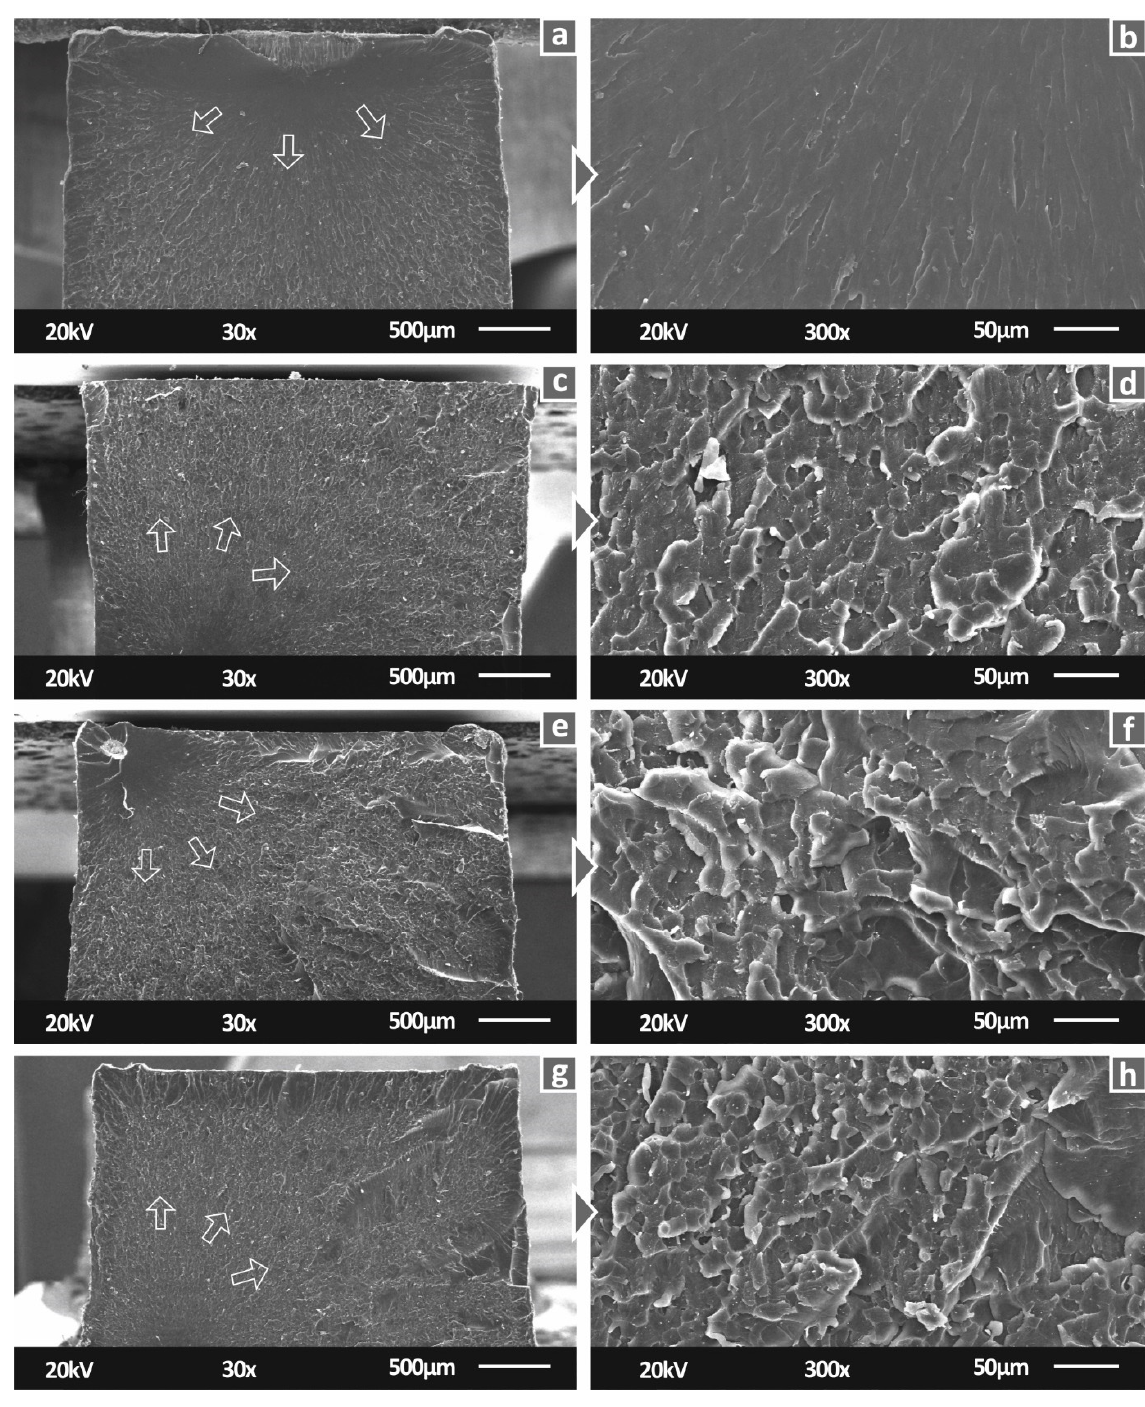
Figure 9. Fracture surface of tensile specimens in 30× magnification for ( a ) Pure SC, ( c ) SC Cu 0.5 wt.%, ( e ) SC Cu 1.0 wt.%, ( g ) SC Cu 2.0 wt.%, same surfaces in 300× magnification for ( b ) Pure SC, ( d ) SC Cu 0.5 wt.%, ( f ) SC Cu 1.0 wt.%, ( h ) SC Cu 2.0 wt.%. Arrows in × magnification for ( b ) Pure SC, the pictures show the fracture evolution in the section. wt.%, ( e ) SC Cu 1.0 wt.%, ( g ) SC Cu 2.0 wt.%, same surfaces in 300 ( d ) SC Cu 0.5 wt.%, ( f ) SC Cu 1.0 wt.%, ( h ) SC Cu 2.0 wt.%. Arrows in the pictures show the fracture evolution in the